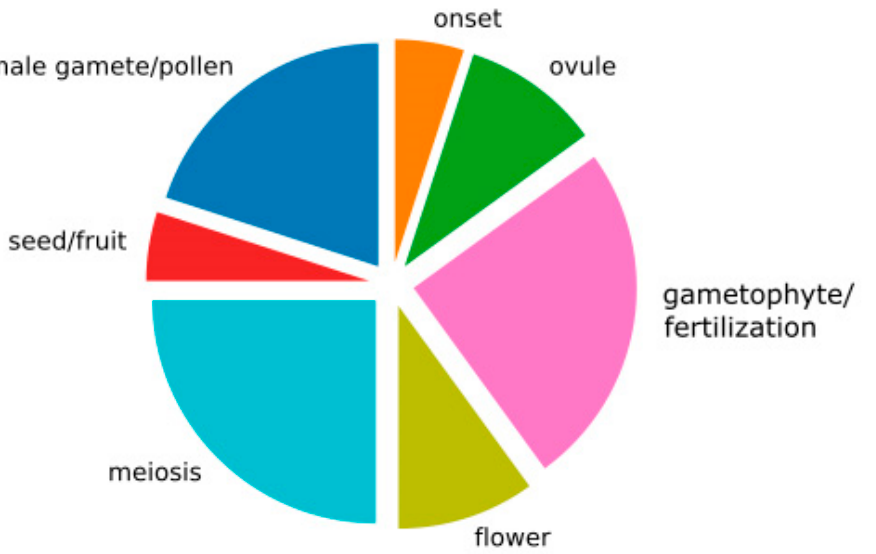
Figure 3. Pie chart of genes involved in reproduction and inferred to be under diversifying selection in the F2 hybrids compared to the parental samples. “Onset” means genes involved in onset of reproductive process.